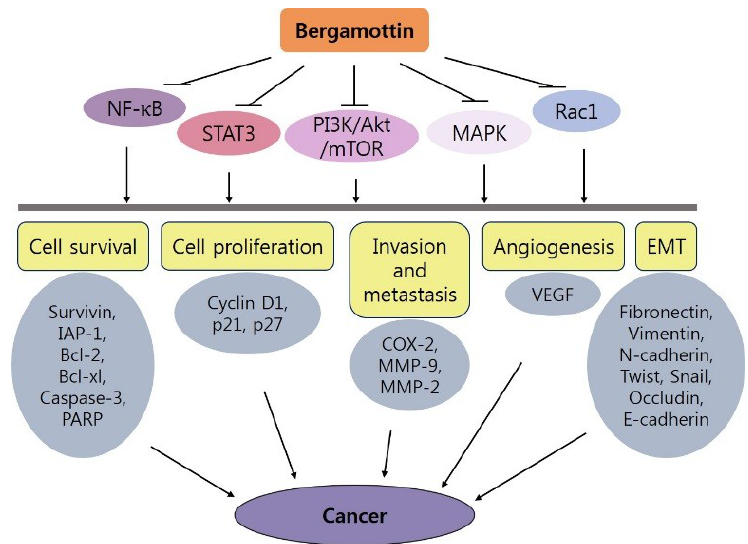
Figure 3. Proposed mechanisms of the anti-cancer activity of bergamottin.